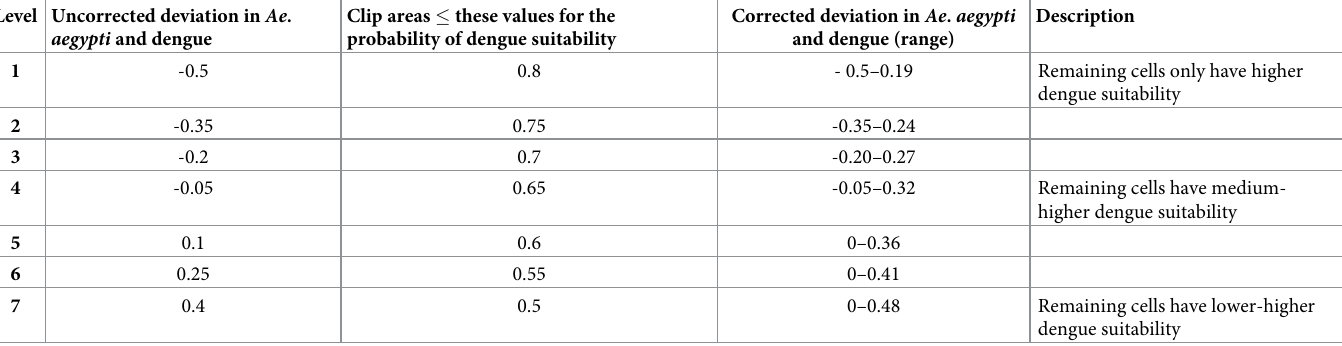
Table 1. Correction to the deviation between Ae . aegypti and dengue map by clipping out respective areas with a lower probability of dengue environmental suitability. Level Uncorrected deviation in Ae